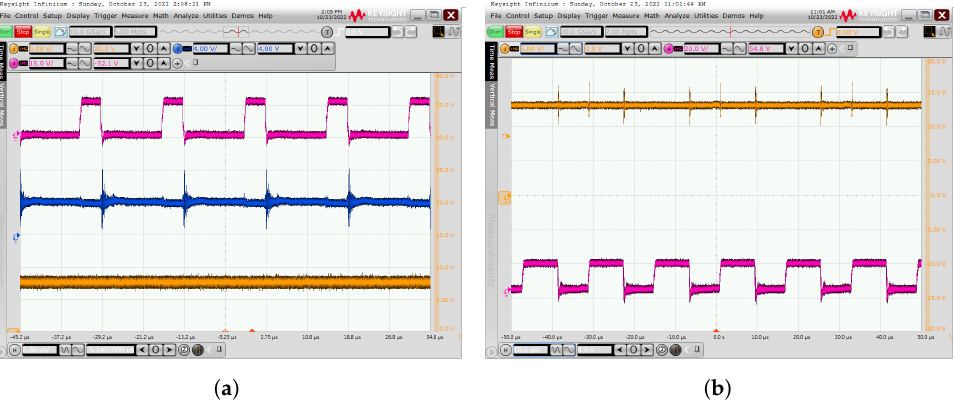
Figure 13. Experimental result waveforms: ( a ) PWM, V s , V out in open loop; ( b ) output voltage with PI